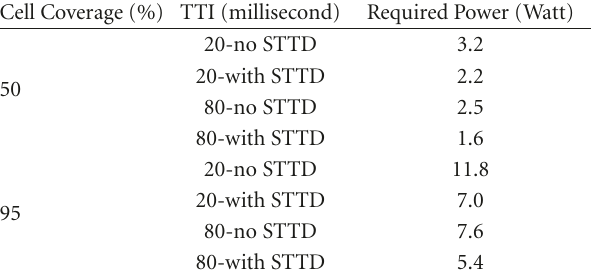
Table 3: Indicative FACH Tx power levels with Usage of longer TTI and space